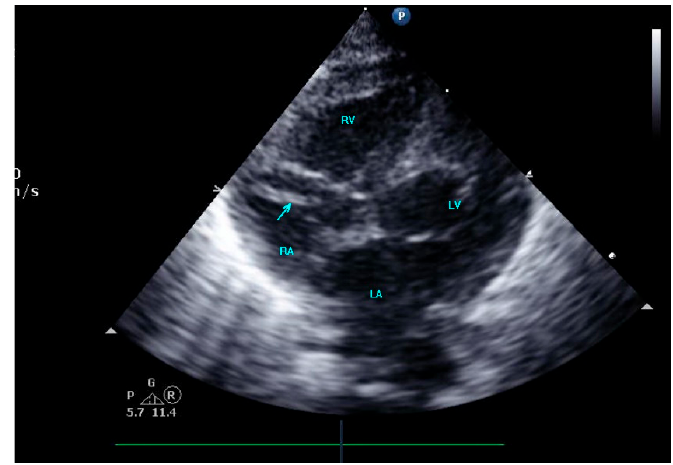
Figure 2. The umbilical venous catheter in the right atrium.